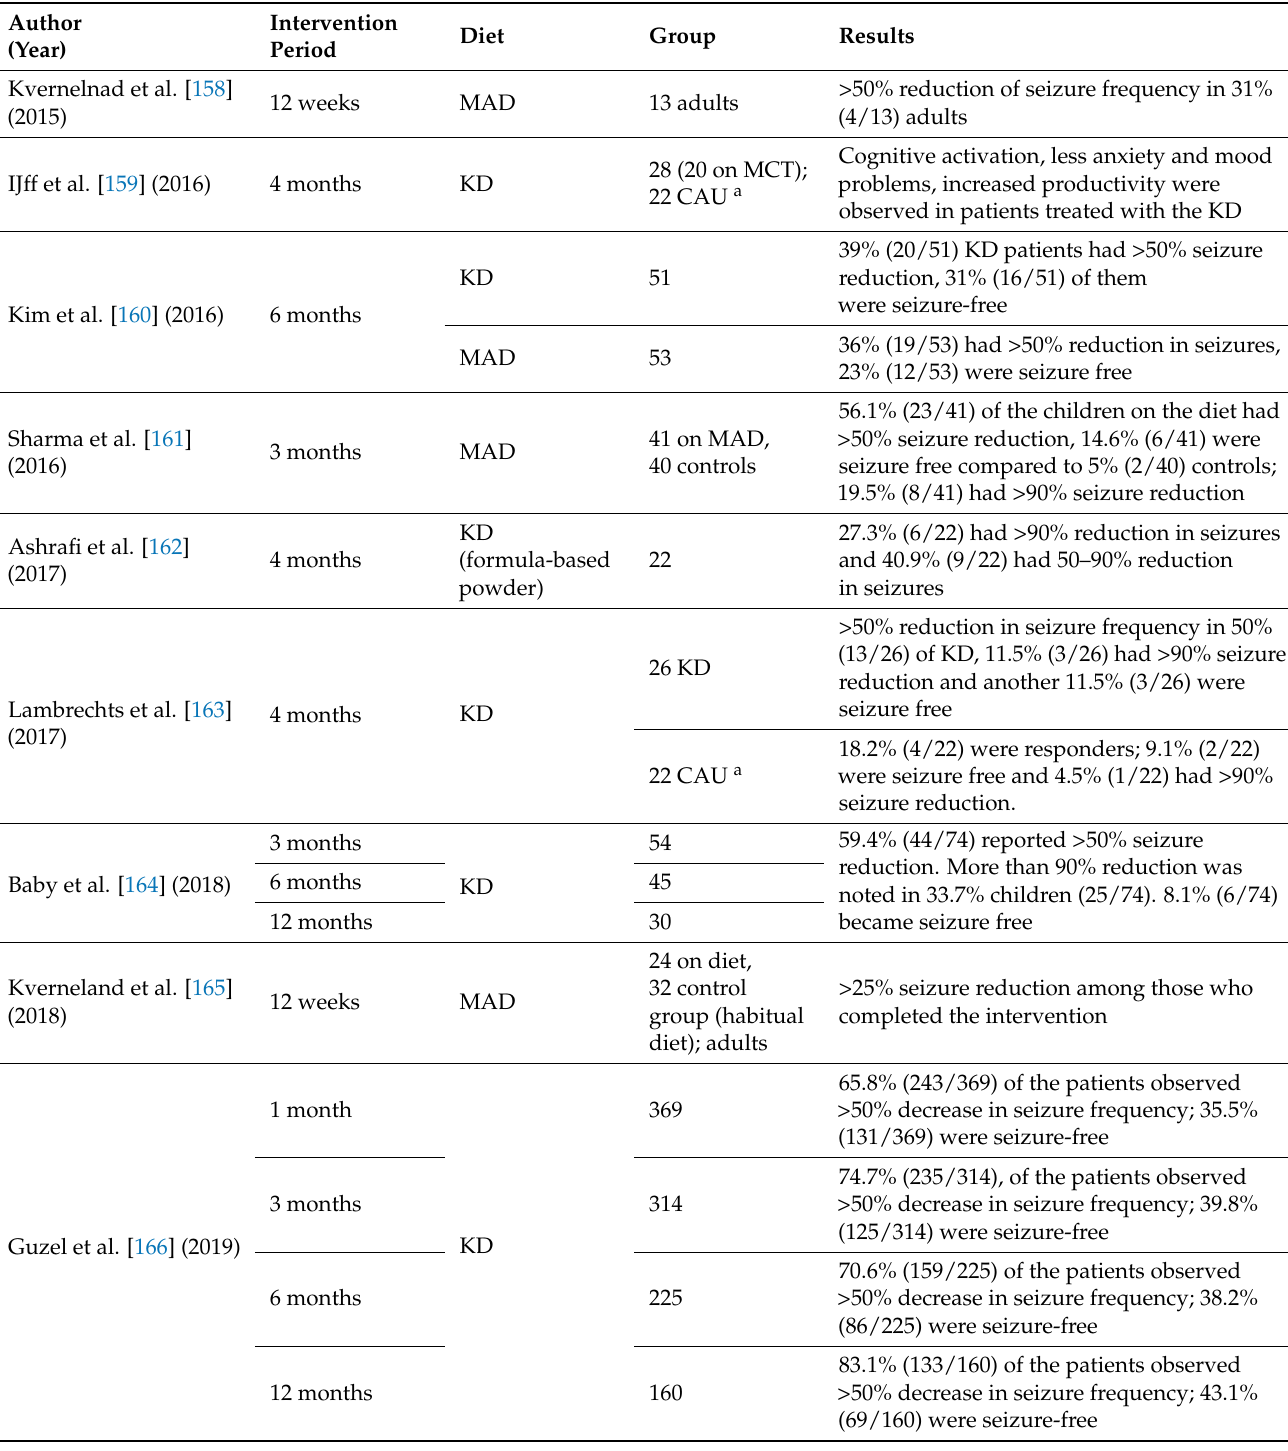
Table 1. Results of clinical trials and randomized controlled trials conducted over the past 7 years involving patients with epilepsy to determine the efficacy and tolerability of the ketogenic